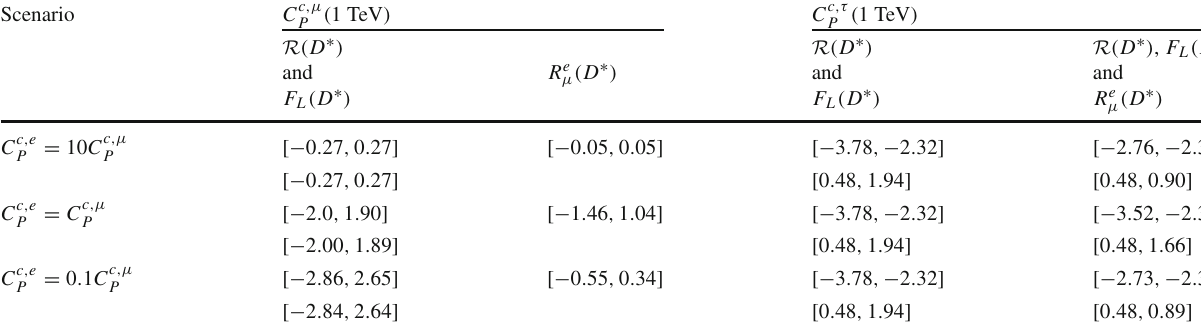
,μ and C c ,τ in different scenarios correlating C c , e P P